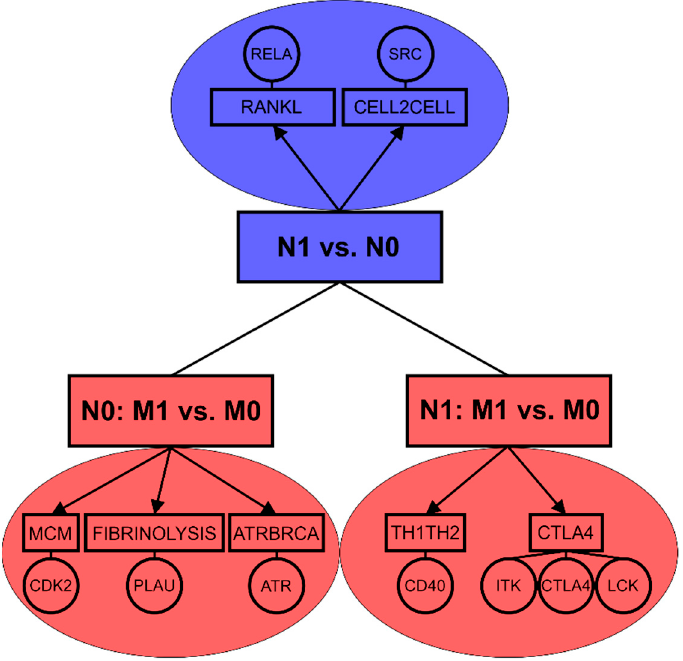
Figure 2. Enriched pathways and key biomarkers associated with lymph node metastasis (N1 vs. N0) and distant metastasis based on lymph node status (N0: M1 vs. M0, N1: M1vs.M0) in luminal A breast tumors.